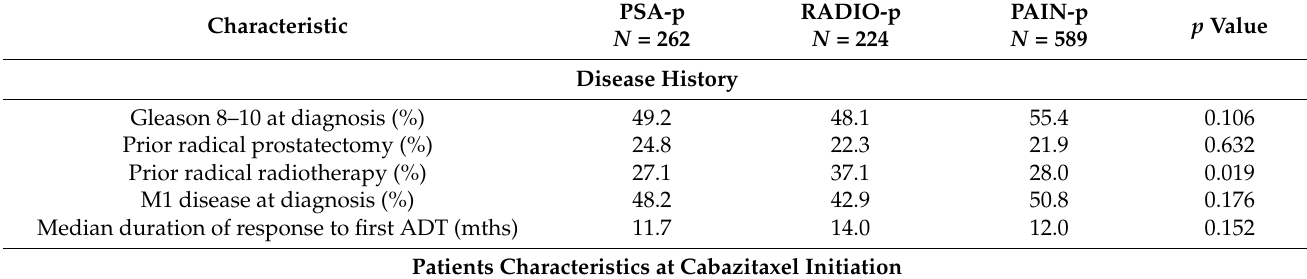
Table 1. Patient characteristics at disease diagnosis and at cabazitaxel initiation by type of disease progression. PSA-p Characteristic